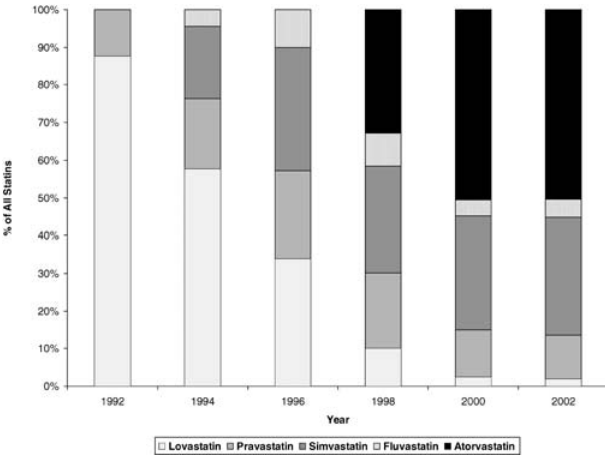
Figure 1. Use of Statins and All Lipid-Lowering Medications among United States Ambulatory Visits by Patients Diagnosed with Hyper- lipidemia